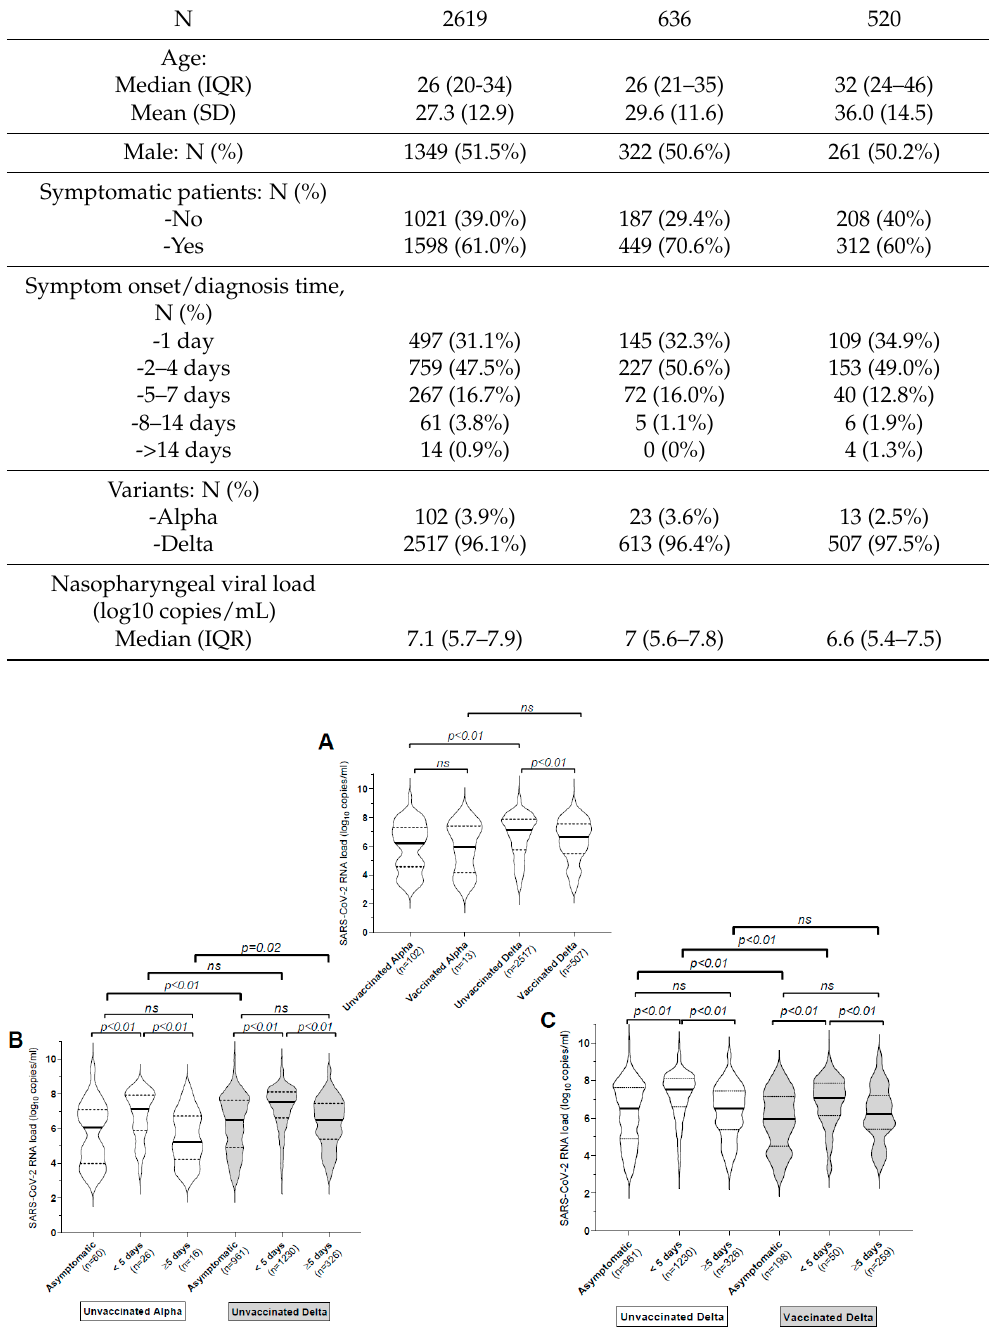
Figure 1. SARS-CoV-2 RNA loads in nasopharyngeal specimens from infected individuals. Data are represented as violin plot with medians (thick midlines) plus interquartile range (IQR) (top and bottom dotted lines). The number of patients in each group and the p values for comparisons be- tween groups (Mann–Whitney U-test) are shown. ns: not significant. ( A ) Viral loads in subjects with different variants (Alpha/Delta) and their immunization status. ( B ) Viral loads of unvaccinated COVID-19 patients infected with the Delta and Alpha variants, according to symptoms and sam- pling time after symptom onset. ( C ) Viral loads of unvaccinated and fully vaccinated COVID-19 patients infected with the Delta variant, according to symptoms and sampling time after symptom onset.